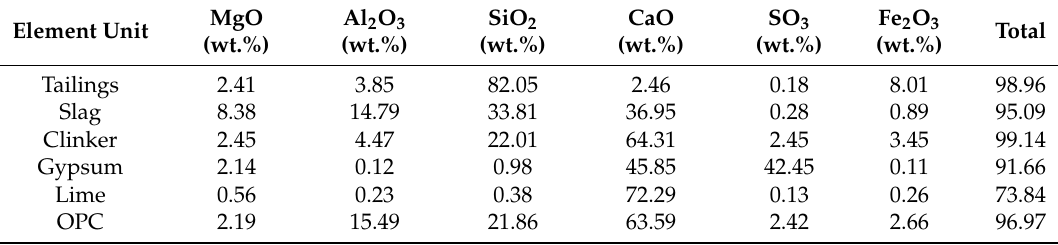
Table 2. Main chemical properties of the materials (OPC: ordinary Portland